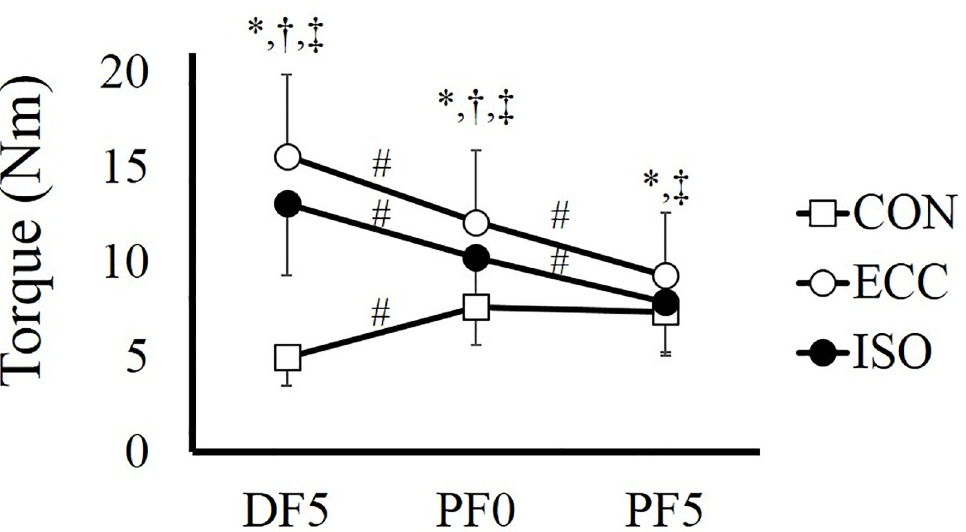
Fig 4. Joint torque recorded at DF5°, PF0°, and PF5° in CON, ECC, and ISO conditions. # indicates a significant difference among joint angles in each contraction condition ( P < 0.05). * indicates a significant difference between CON and ECC at each joint angle ( P < 0.05). † indicates a significant difference between CON and ISO at each joint angle ( P < 0.05). ‡ indicates a significant difference between ECC and ISO at each joint angle ( P < 0.05). CON; concentric contraction without preliminary contraction, ECC; concentric contraction after preliminary eccentric contraction, ISO; concentric contraction after preliminary isometric contraction, DF; dorsiflexion, PF;